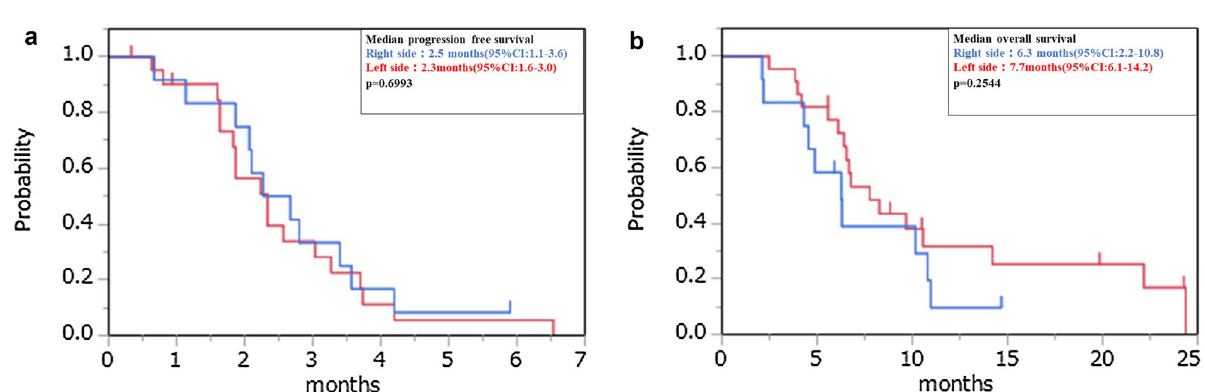
Figure 3. Kaplan–Meier plots of ( a ) progression-free survival (PFS) and ( b ) overall survival (OS) among study participants. Red line: Left side tumor; Blue line: Right side tumor.